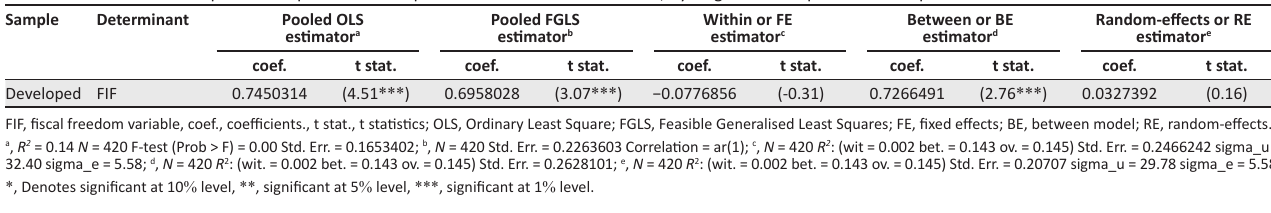
TABLE 3: Variation of Corruption Perceptions Index depends on fiscal freedom variable, by stage of development: Developed. Sample Determinant